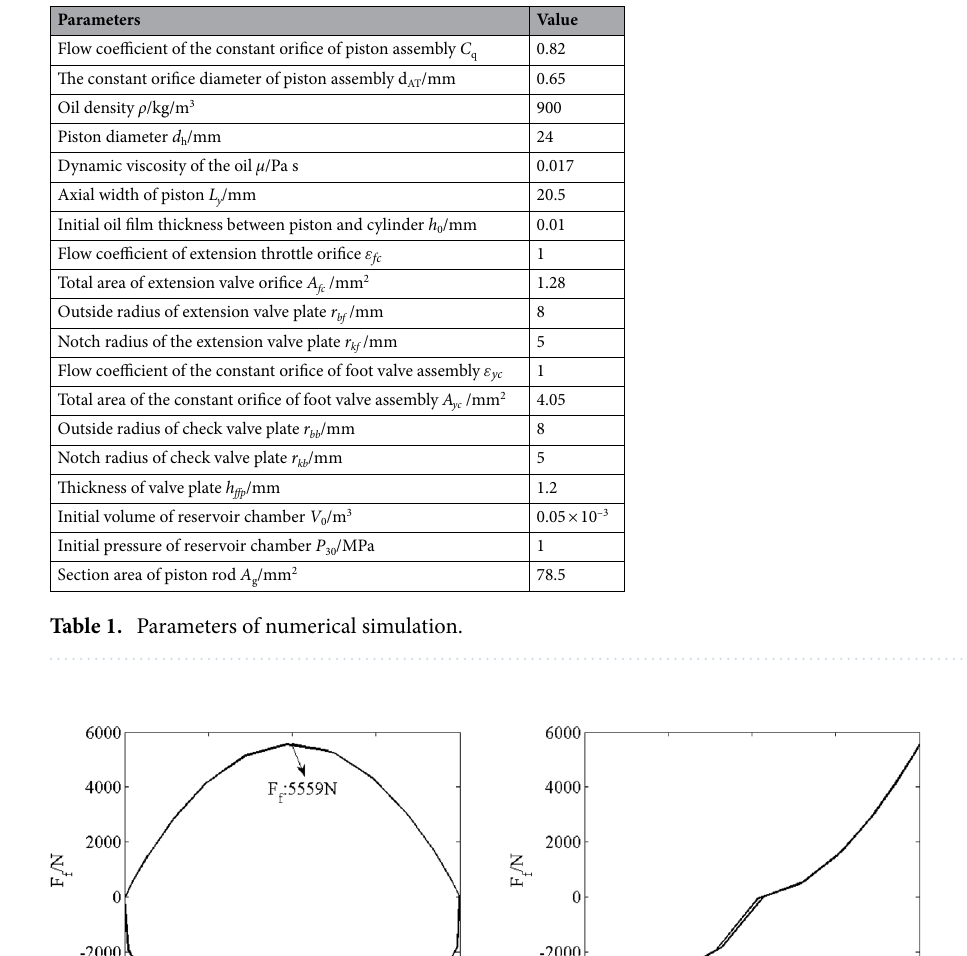
(6185 N) greatly increases by 11.26%. As a result, the friction force since the cylindrical texture eccentric piston has great effects on damping characteristics, as shown in Figs. 7c and 10c,d. Piston is inclined and eccentric. The friction force F foil of the inclined and eccentric piston and the cylindri- cal textured inclined and eccentric piston are shown by simulating with the depth ratio δ from 0.01 to 0.14 in Fig. 11a. The difference Δ F foil of friction force of the cylindrical texture inclined and eccentric piston and inclined and eccentric piston is shown in Fig. 11b. The friction force F foil of the cylindrical texture inclined and eccentric piston increases with increasing the depth ratio δ from 0.01 to 0.14. The friction force F foil and depth ratio δ shows parabolic curve relationship with increasing depth ratio δ from 0.01 to 0.14. Compared with friction force F foil of inclined and eccentric piston (930.3 N), when the depth ratio δ is increased to 0.14, the friction force F foil of the cylindrical textured inclined and eccentric piston (1682 N) greatly increases by 80.8%. As a result, the cylindrical texture under inclined and eccentric piston condition has great effects on the friction force F foil . As shown in Fig. 11c,d, Compared with the damping force F f of inclined and eccentric piston (6496 N), when the depth ratio δ is increased to 0.14, the damping force F f the cylindrical textured inclined and eccentric piston (7123 N) greatly increases by 9.65%. Therefore, it is worth noting that the piston eccentricity plus inclination with cylindrical texture has great effect on damping force. As shown in Fig. 11e,f, the area of damping force–displace- ment loop increases with increasing depth ratio δ . As shown in Figs. 7 and 11c,d, taking the damping force F f of piston (5559 N) as the baseline value, when depth ratio δ is increased to 0.14 and the eccentricity e is 0.6h 0 , the damping force F f of the cylindrical textured inclined and eccentric piston (7123 N) greatly increases by 28.13%. As shown in Figs. 9c,d, 10c,d and 11c,d, it can be concluded that, compared with inclined piston with cylindrical texture or eccentric piston with cylindrical texture, the damping force F f of the inclined and eccentric pistion with cylindrical textured not only is greater, but also is greater than combination of two situations.